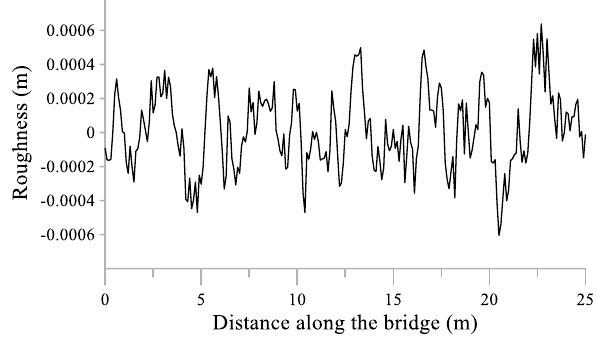
Figure 12. A typical profile of road surface roughness.